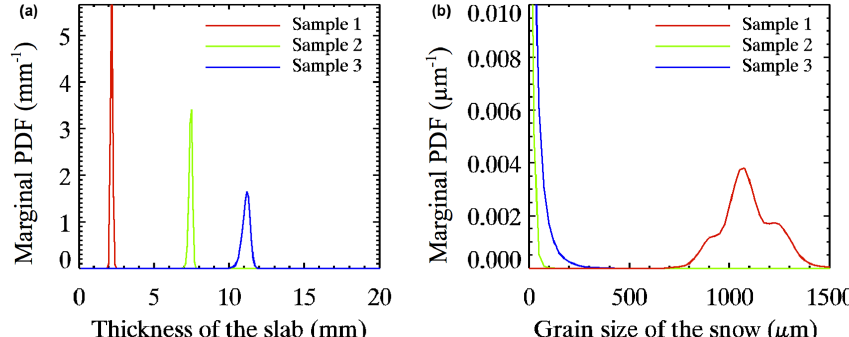
Figure 11. Marginal a posteriori probability density functions for (a) the thickness of the slab P { p 1 (i) } and (b) the grain diameter of the snow substrate P { p 2 (j) } for the three samples, and for the geometries described in Fig. 10.